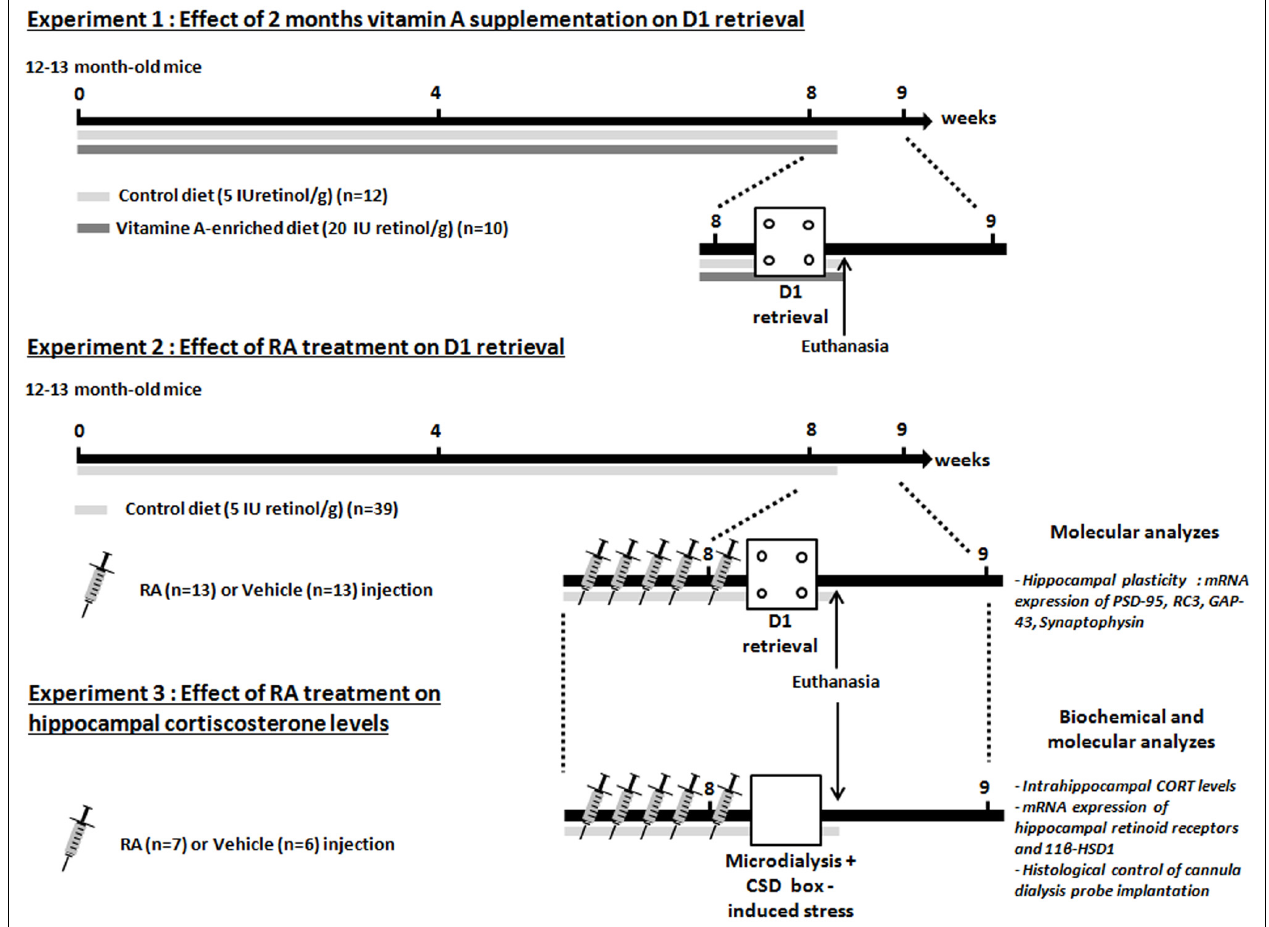
FIGURE 1 | Experimental design. Three experiments are carried out. Experiments 1 and 2 are designed to compare the effects of vitamin A supplementation and RA treatment on memory retrieval in the contextual serial discrimination (CSD) task. The Experiment 3 aims to determine the effects of RA treatment on hippocampal CORT relevels in novelty-induced stress. At the end of the Experiments 2 and 3,